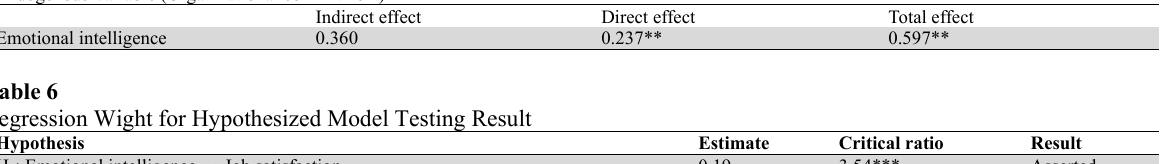
Total Effects of mediator in the Research Model Endogenous Variable (Organizational commitment)